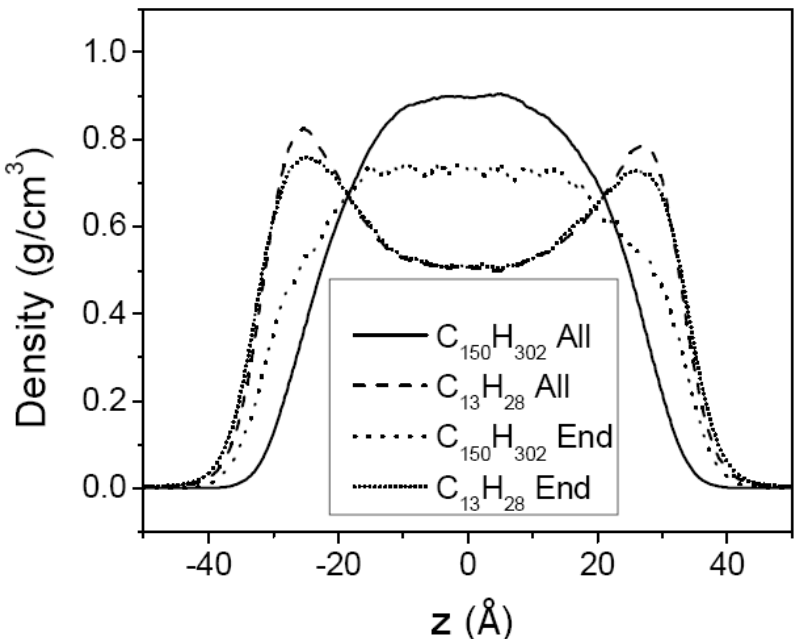
Figure 9. The density profile of methyl end groups of (C 13 H 28 + C 150 H 302 ) mixture melt film at 450 K. The dotted line is the density of methyl groups of C 150 H 302 , and the short-dotted line is that of C 13 H 28 . The all-atom density profile of C 150 H 302 (solid line) and that of C 13 H 28 (dashed line) are shown for comparison. The density of each species is normalized to that of all chain atoms; see the caption for Figure 3.